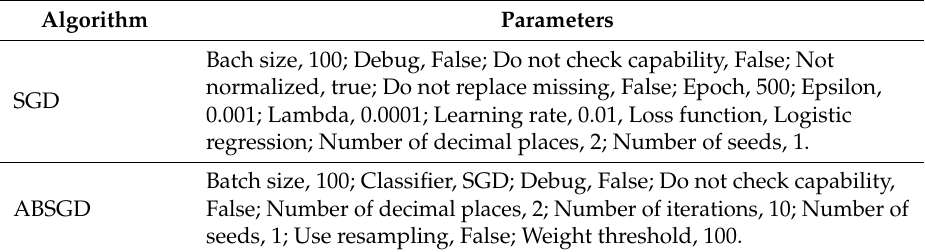
Table 4. Parameters of machine learning algorithms applied in this